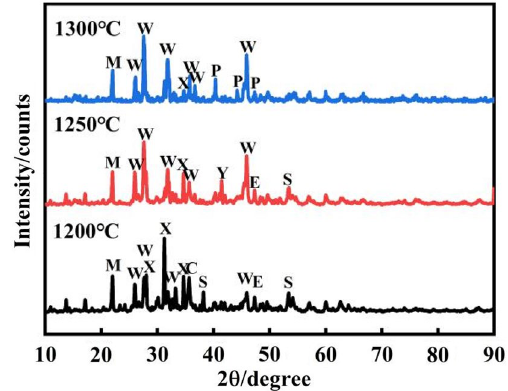
Fig. 5 XRD patterns of the products at different temperatures(C- Fe O 3 4 ;